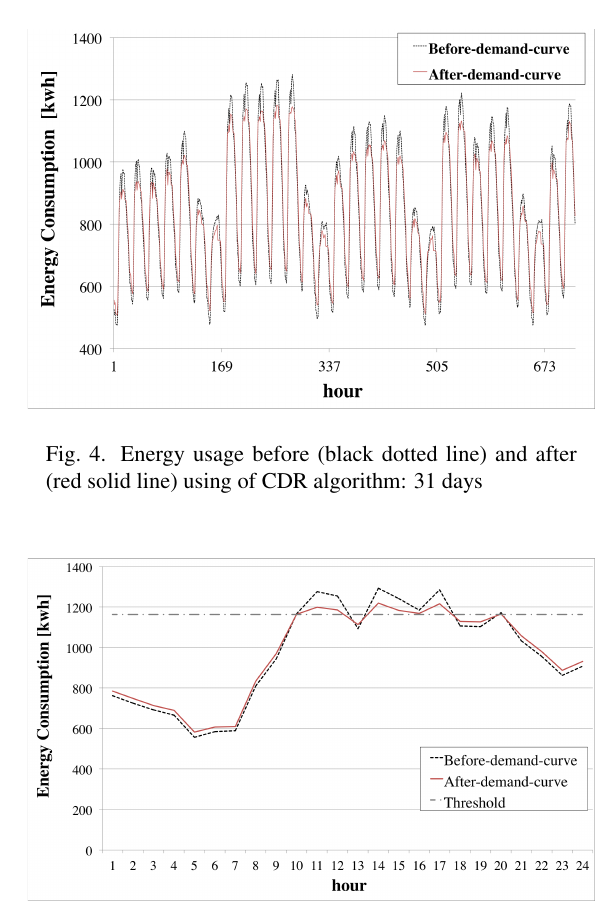
Fig. 5. Energy usage before (black dotted line) and after (red solid line) using of CDR algorithm: 24 hours